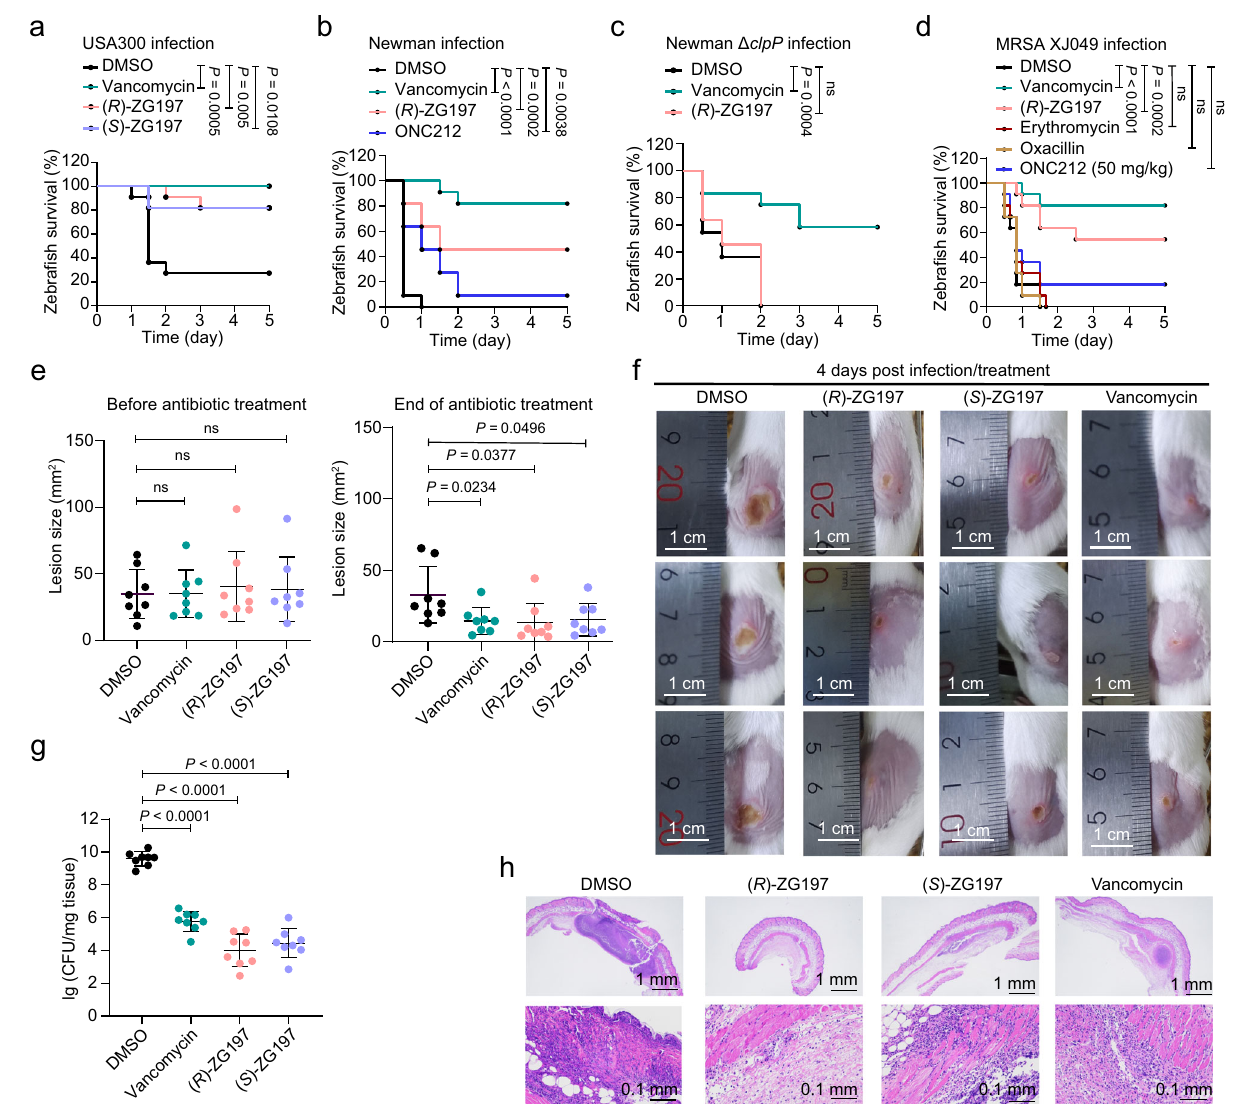
Fig.6|Anti-infectiveeffectsof( R )-and( S )-ZG197invivo.a Therapeuticeffectof ( R )- and ( S )-ZG197 against USA300 infection in zebra fi sh. Zebra fi sh ( n =11 animals) were infectedwith 7×10 6 CFUof USA300, and compounds wereadministered ata single dose of 50mg/kg. DMSO (5%) and vancomycin were administered as con- trols. Therapeutic effect of ( R )-ZG197 against lethal infection by Newman ( b ) and the Δ clpP mutant ( c ). Zebra fi sh ( n =11 animals) were infected with 7×10 7 CFU of Newman ( b ) or 3×10 7 CFU of the Δ clpP mutant ( c ), and compounds were admi- nistered to infected zebra fi sh at 50mg/kg. Vancomycin and ONC212 were used as controls. d Therapeutic effect of ( R )-ZG197 on the clinical MRSA isolates infected zebra fi sh. Zebra fi sh ( n =11 animals) were infected with 5×10 7 CFU of XJ049, and compoundswereadministeredatasingledoseof50mg/kg.DMSO(5%),antibiotics (vancomycin, erythromycin, and oxacillin), and the global activator ONC212 were